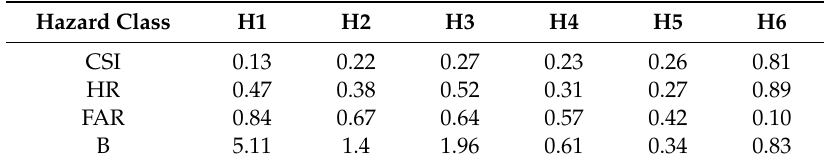
Figure 9. Flooded areas belonging to specific AIDR hazard classes as simulated by the two model: T = 200 years and grid resolution equal to 5 m ( a ) and 10 m ( c ), T = 30 years and grid resolution equal to 5 m ( b ) and 10 m ( d ). Table 4. Value of the performance indexes related to flooded areas extent of each hazard class (T = 30 years).